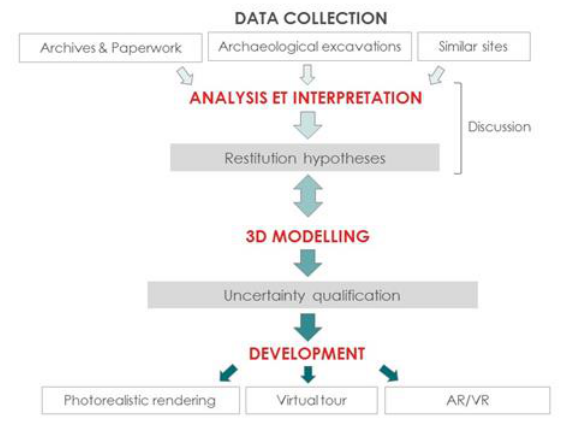
Figure 1. General project